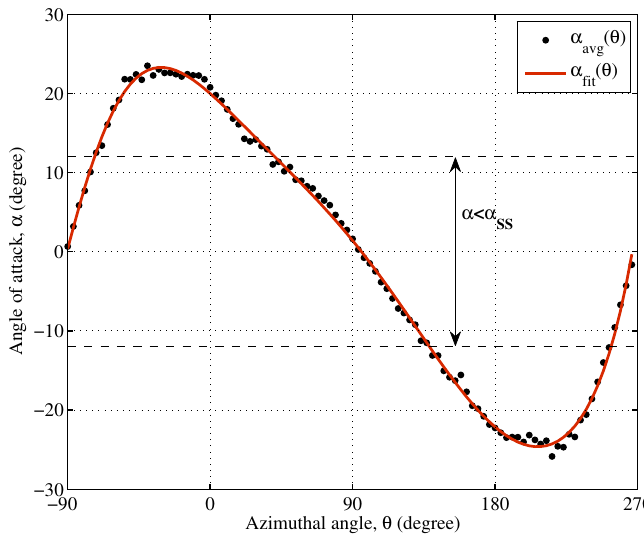
Figure A1. The time-averaged (black circles) and curve-fitted (red line) behavior of the variation of angle of attack as a function of azimuthal angle in one revolution of a blade